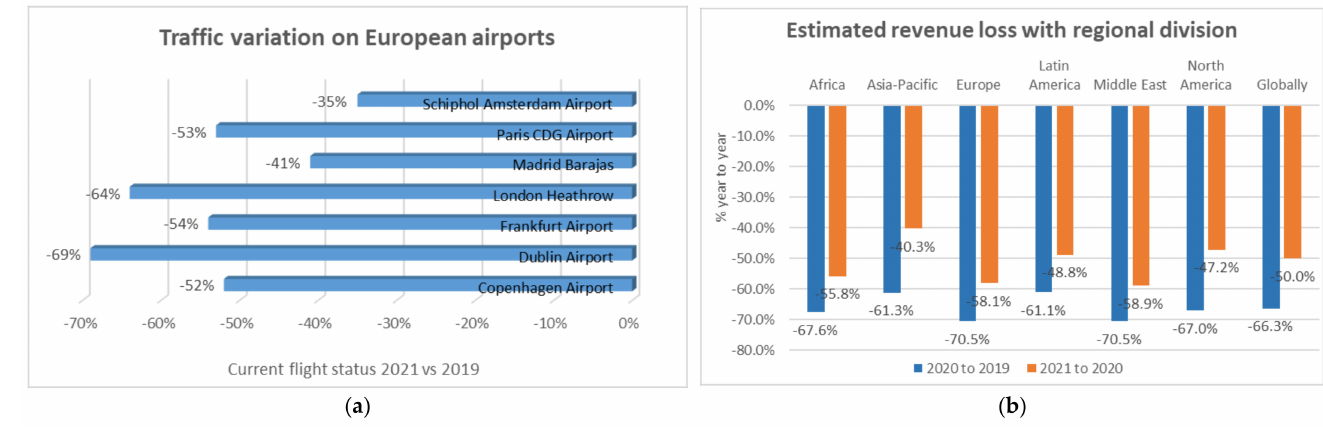
Figure 2. Background of the research: ( a ) Passengers and cargo indices with regional division, % year 2021 versus year 2019, own work, based on [1]; ( b ) Estimated revenue loss with regional division,